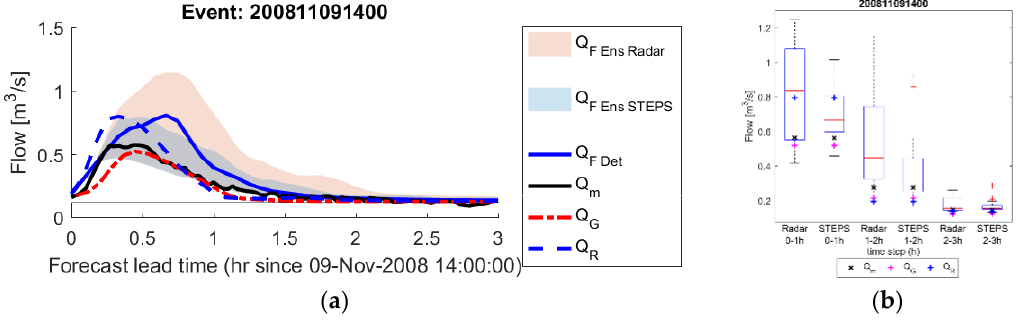
Figure 12. Flows ( a ) and peak flows ( b ) for events on 09 November 2008 starting at 14:00. Q F Ens Radar, Q F Ens STEPS , Q F Det, Q m , Q G and Q R are, respectively, forecasted radar ensemble flows, forecasted STEPS ensemble flows, forecasted deterministic flow, measured flow, estimated gauge flow and estimated radar flow.